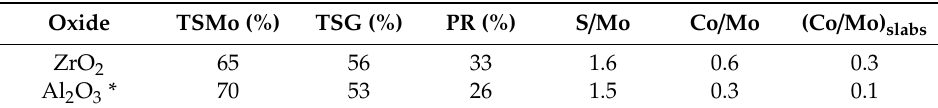
Table 2. Parameters characterizing the active